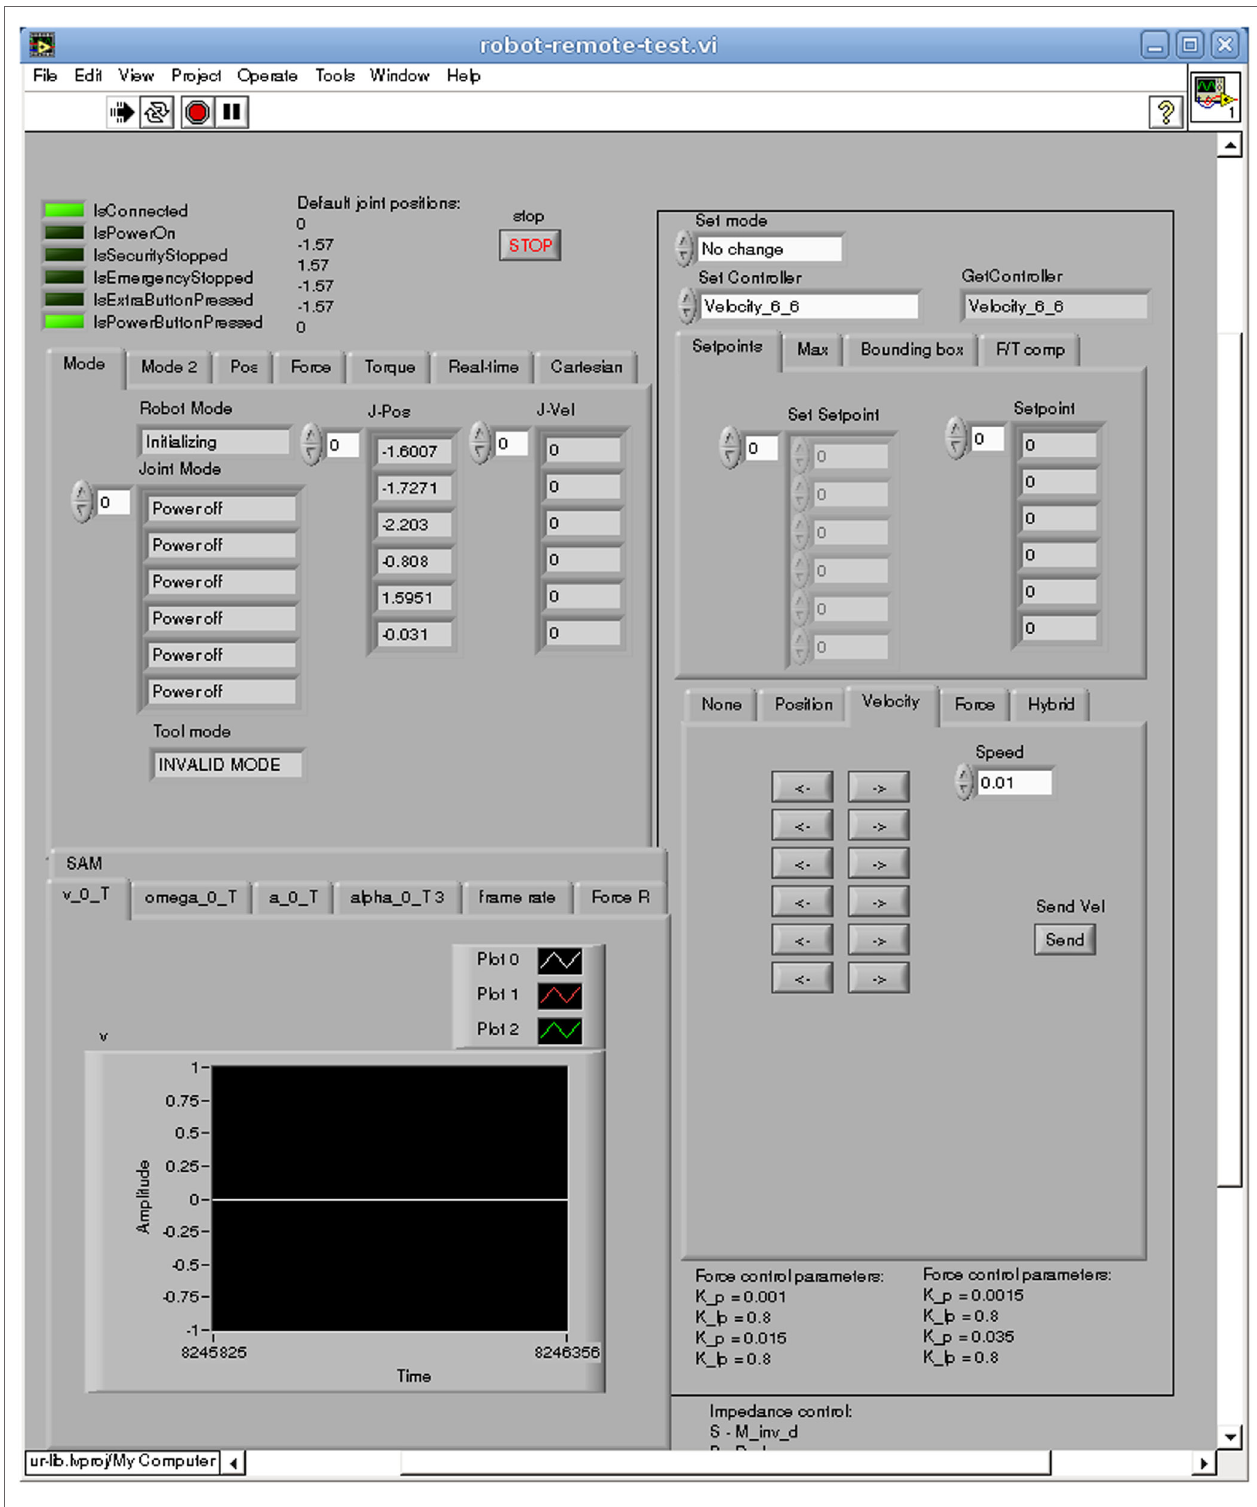
FigUre 3 | The user interface of the system, where status information about the robot is shown, control modes are selected and sensor data displayed.